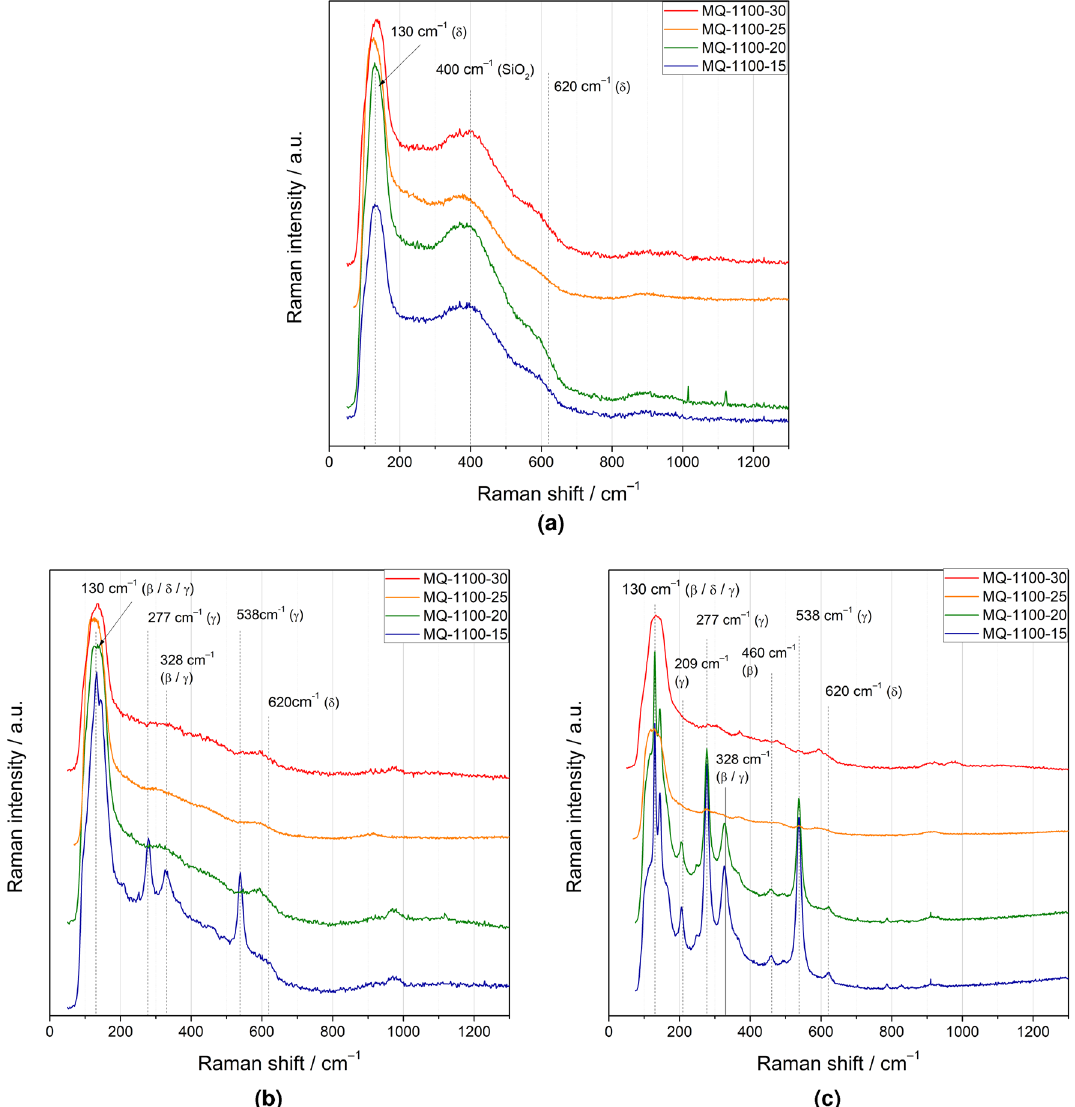
Figure 7. Room temperature Raman spectra of as-synthesized glasses ( a ) and the samples after heat-treatment ◦ ◦ at 630 C ( b ) and 730 C ( c ). The peaks have been tentatively assigned to various crystalline phases of Bi 2 O 3